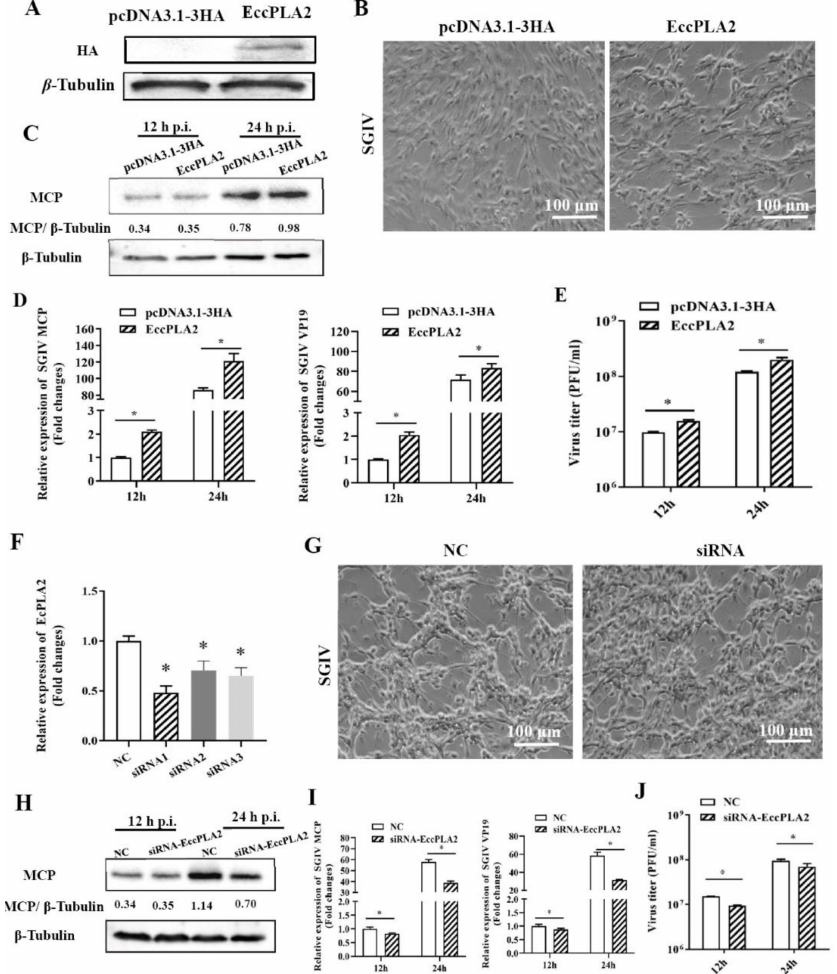
Figure 5. The effects of EcPLA2 α overexpression or knockdown on SGIV replication. ( A – E ) Overex- pression of EcPLA2 α enhanced SGIV replication. ( F – J ) Knockdown of EcPLA2 α suppressed SGIV replication. ( A , F ) EcPLA2 α was successfully overexpressed or knocked down in transfected cells. The protein or transcription level of EcPLA2 α in pcDNA3.1-3HA- or 3HA-EcPLA2 α -transfected cells were detected by Western blot or qPCR. ( B ) The CPE induced by SGIV at 24 h p.i. was improved in EcPLA2 α overexpressing cells. ( G ) The CPE induced by SGIV at 24 h p.i. was delayed in EcPLA2 α knockdown cells. ( C , H ) Western blotting analysis of viral MCP during SGIV infection in EcPLA2 α overexpressing or knockdown cells. ( D , I ) The effect of the overexpression or knockdown of EcPLA2 α on SGIV MCP or VP19 transcription during SGIV was examined by qPCR. ( E , J ) The virus production of SGIV in infected cells was examined by virus plaque assay after EcPLA2 α overexpression or knockdown in EAGA cells. Data are expressed as means ± SD. The asterisks (*) indicated p <